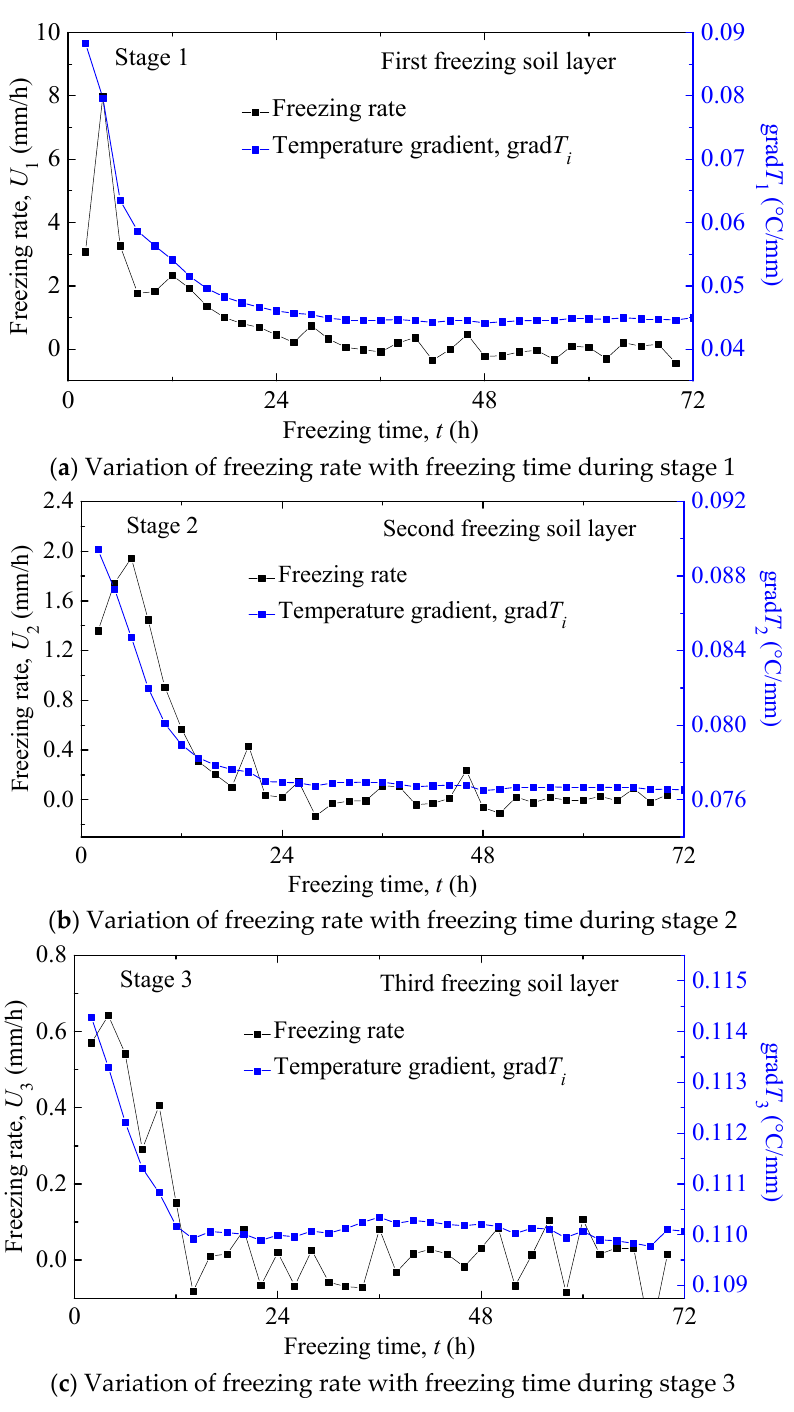
Figure 13. Variations of the freezing rate and temperature gradient with time in the freezing soil layers during ( a ) stage 1, ( b ) stage 2, and ( c ) stage 3.